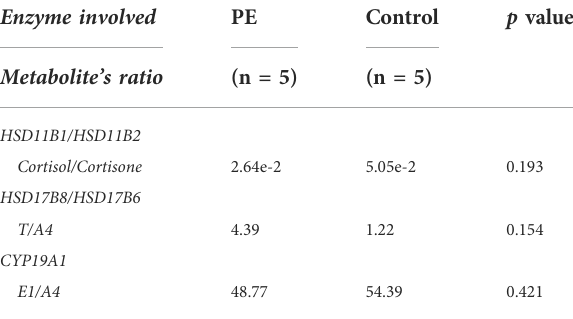
TABLE 2 Activity of the main placental enzymes involved in steroidogenesis in the PE and control groups. Enzyme involved PE